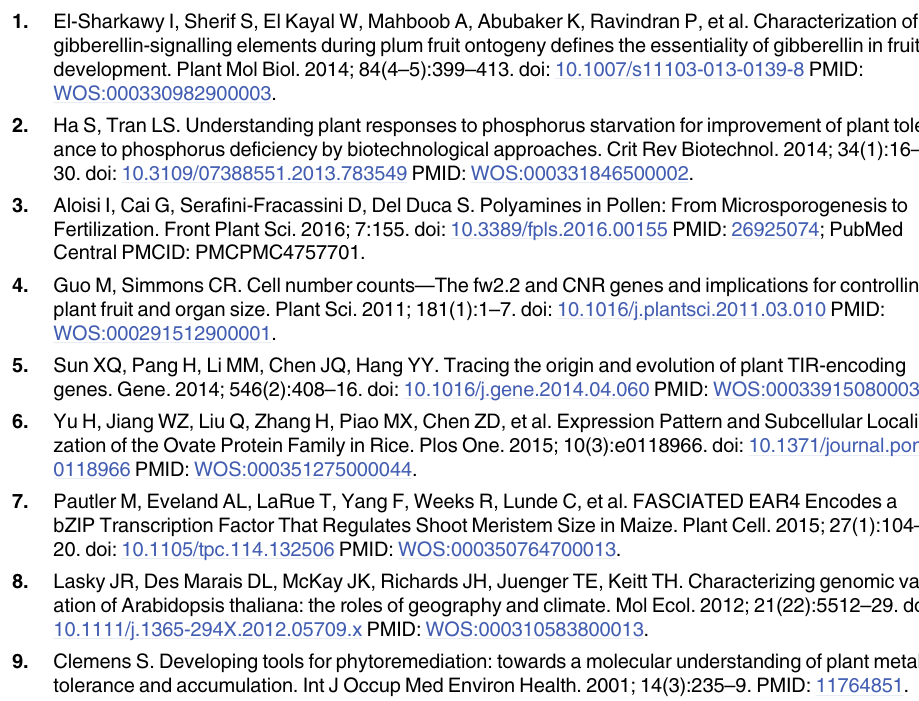
S2 Table. Edge information in the constructed network (part one). S3 Table. Edge information in the constructed network (part two). S4 Table. Edge information in the constructed network (part three). S5 Table. Genes identified by the shortest path-based method. S6 Table. 653 genes filtering by a permutation test, where 136 are validated genes and 517 are novel